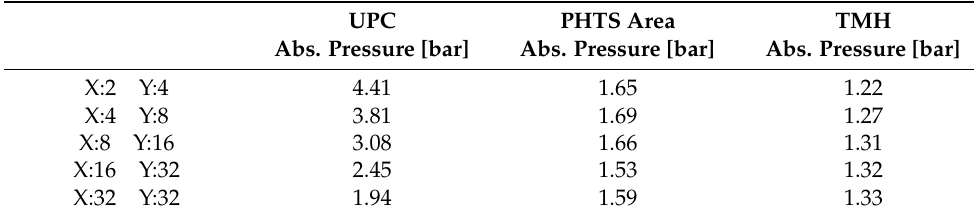
Figure 25. Direct unfiltered release of ACP (%i.i). Table 3. Maximum pressure in the UPC.